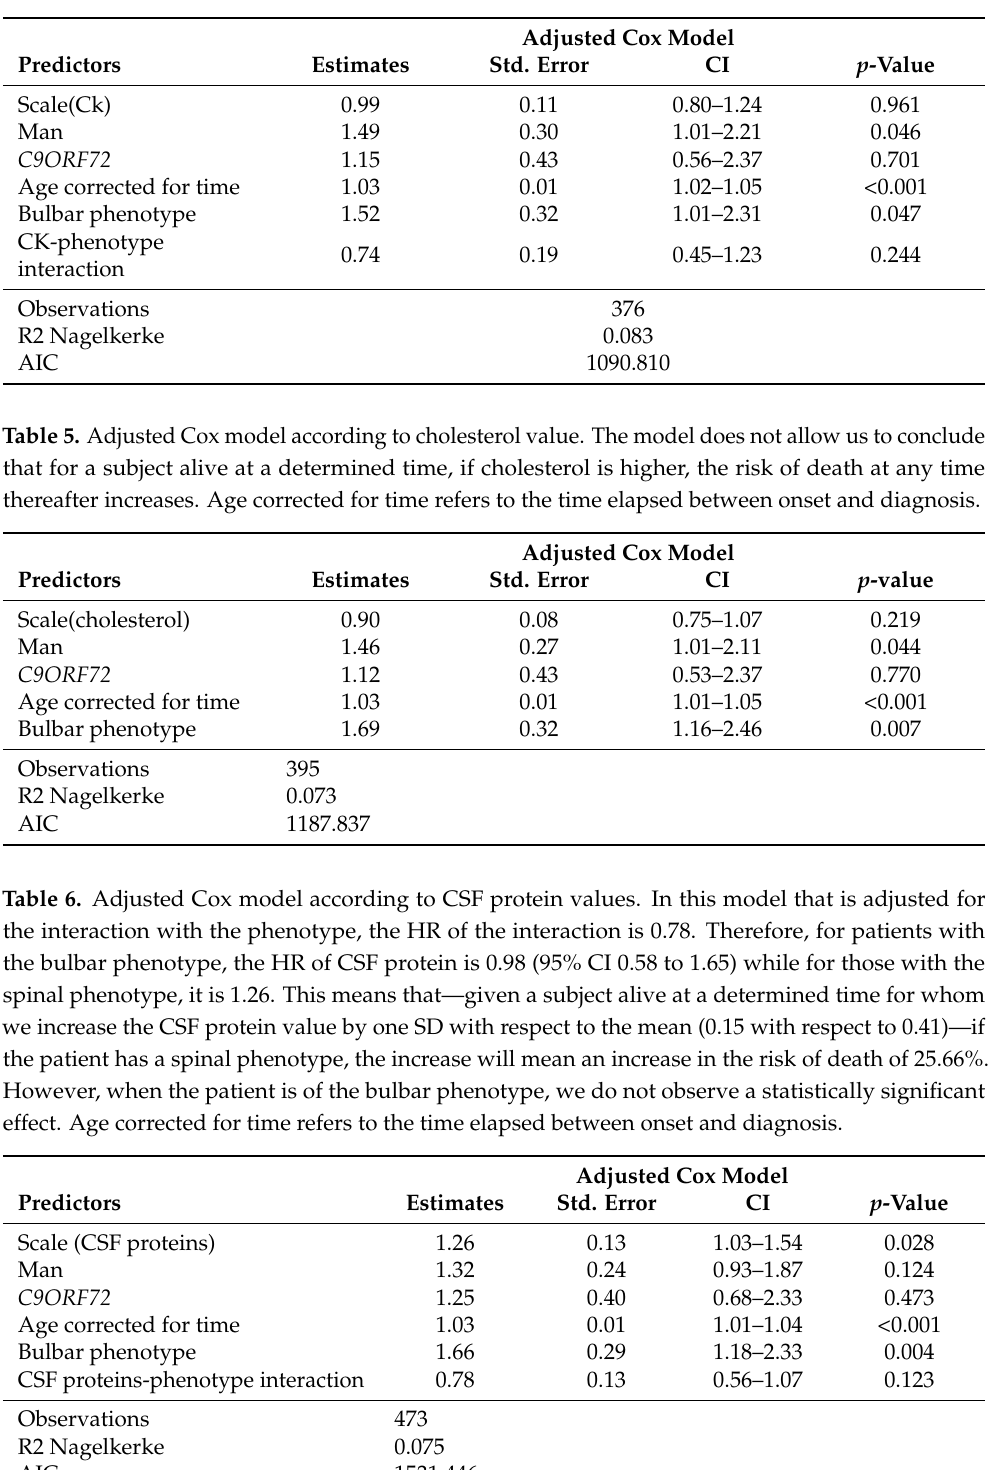
Table 4. Adjusted Cox model based on CK values. The model does not allow us to conclude that for a subject alive at a determined time, if the CK is higher, the risk of death at any time thereafter increases. Age corrected for time refers to the time elapsed between onset and diagnosis.